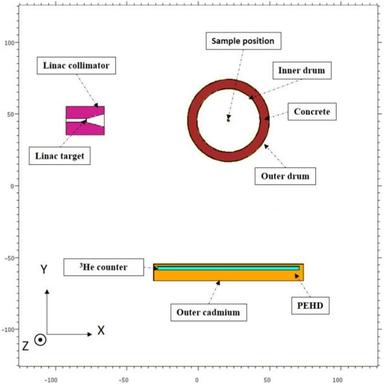
2D view of the measurement configuration model used in MCNP6 simulations.